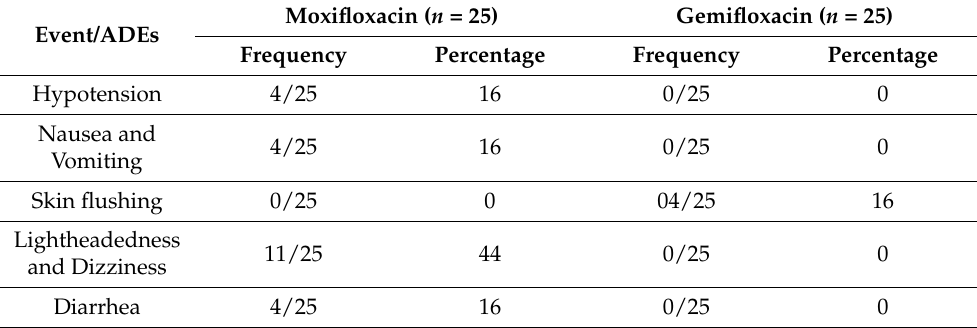
Table 3. QTc interval measured in milliseconds in twenty-five participants treated with Moxiflox- acin .